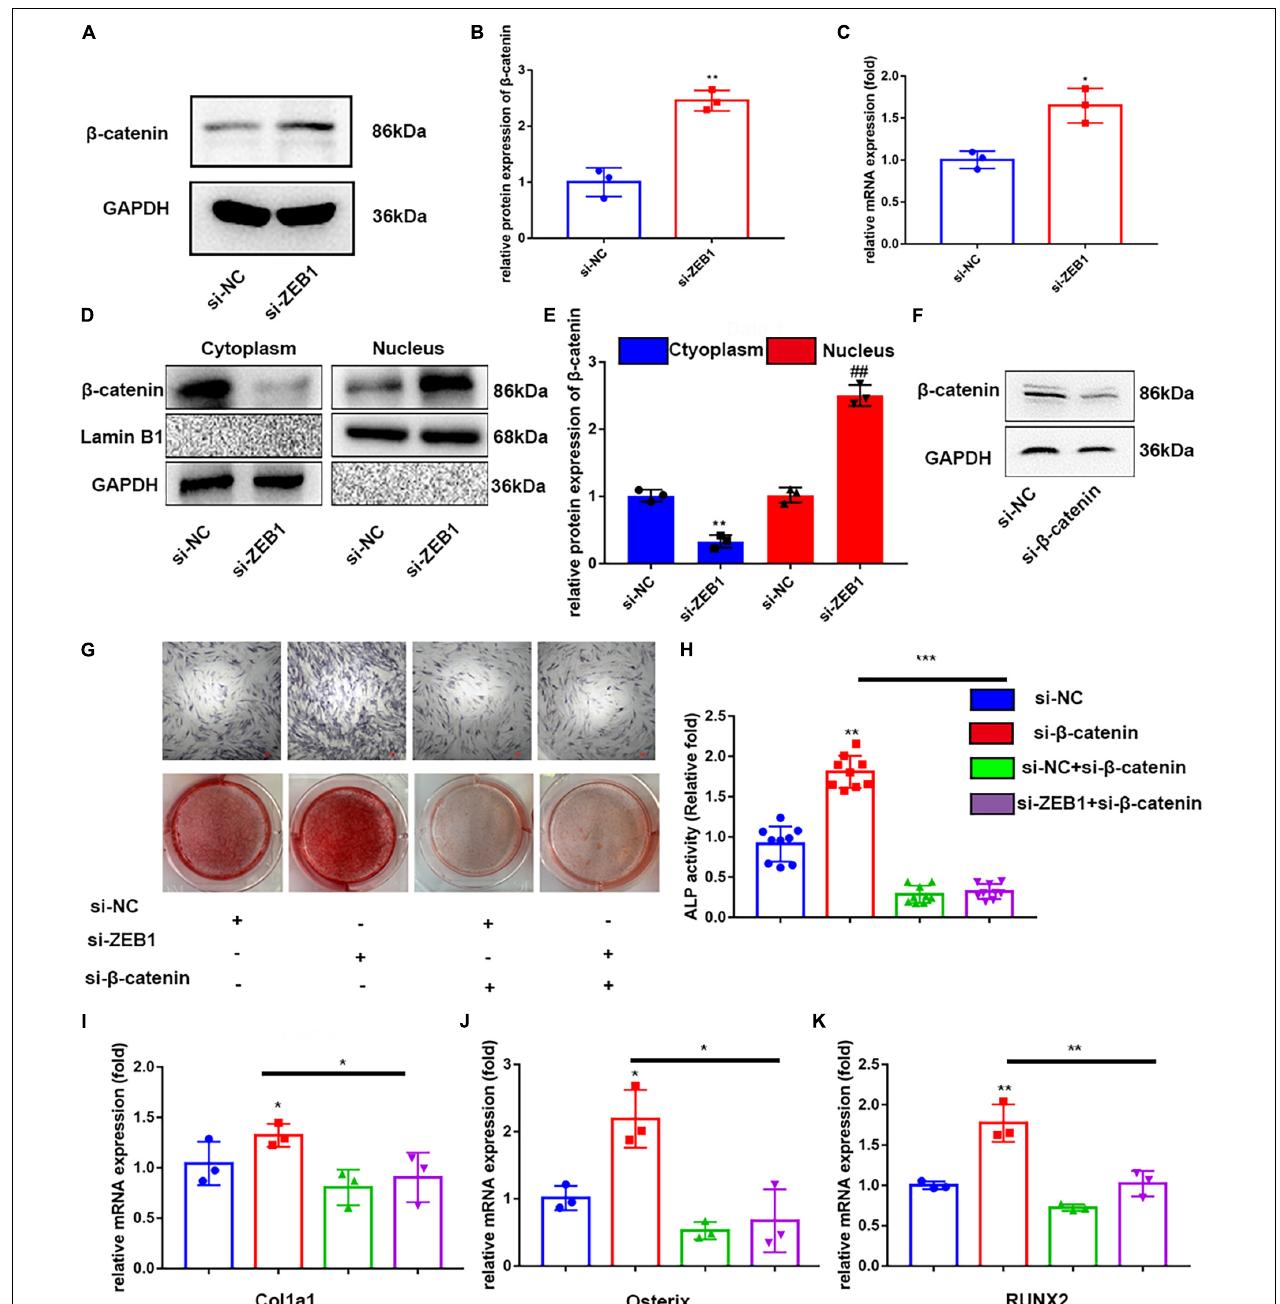
FIGURE 4 | Downregulation of endogenous ZEB1 activated wnt/ β -catenin signaling pathway. (A,B) Western blotting analysis showed that ZEB1 knockdown promoted the protein level of β -catenin. (C) qRT-PCR analysis revealed that ZEB1 knockdown promoted the mRNA level of β -catenin. (D,E) β -catenin protein level was increased in the nucleus evaluated by qRT-PCR. (F) β -catenin expression was decreased after si β -catenin treatment – evaluated by western blotting. (G) ALP staining and alizarin red staining of hBMSCs after si β -catenin and siZEB1 treatment. (H) ALP activity of hBMSCs after si β -catenin and siZEB1 treatment. (I–K) qRT-PCR exhibited that si β -catenin transfection rescued the increased ALP, osterix, RUNX2, and Col1a1 induced by siZEB1. * p -value < 0.05, ** p -value < 0.01 and *** p -value <